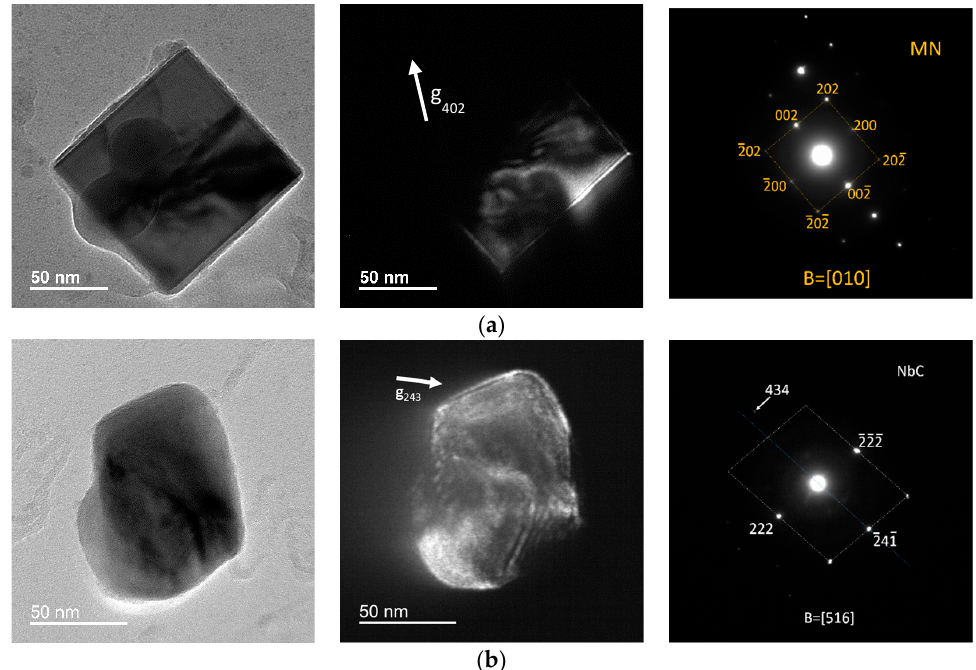
Figure 9. BF–DF and SADP of complex bicrystalline particles found in: ( a ) low-Nb steel austenitized at 1300 °C for 1 h.; ( b ) high-Nb steel austenitized to 1150 °C for 1 h.